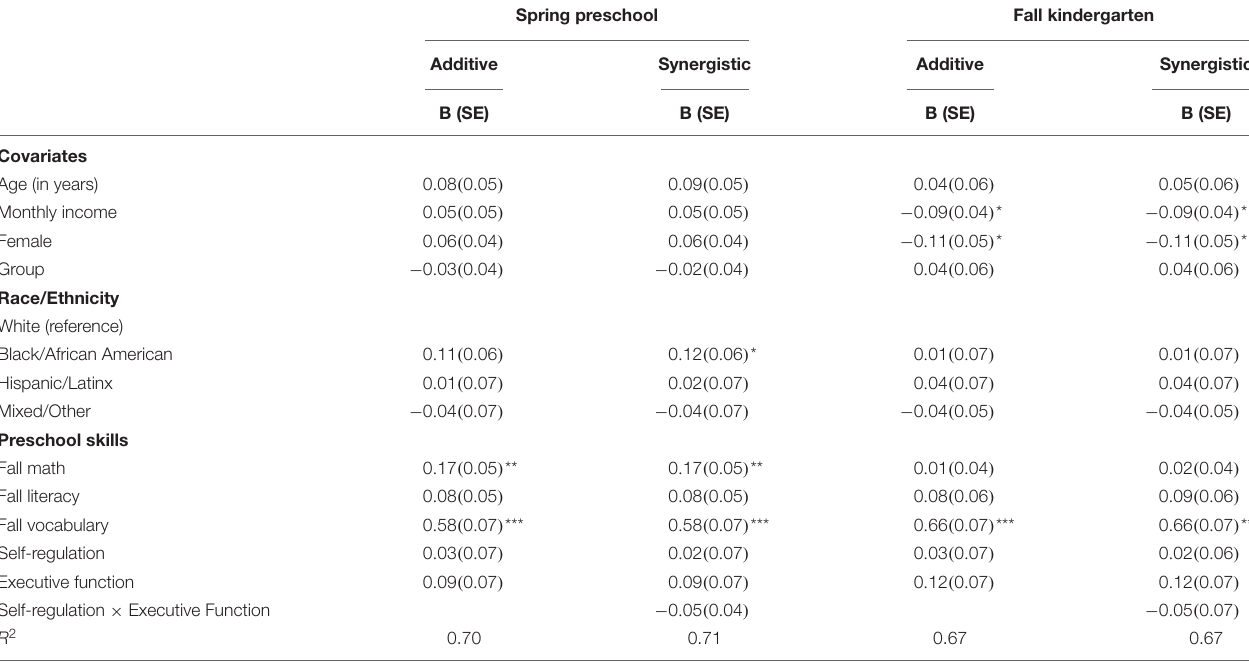
TABLE 5 | Model estimates for additive and synergistic effects of preschool self-regulation and executive function on vocabulary outcomes. Spring preschool